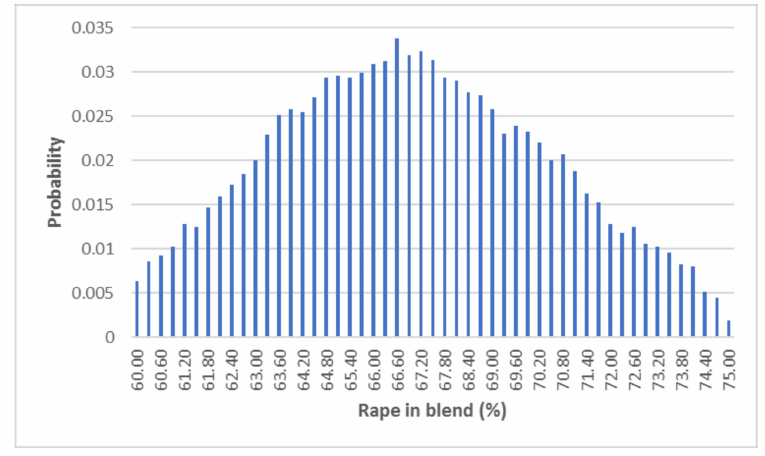
Figure 15. Monte Carlo representation of the complete design